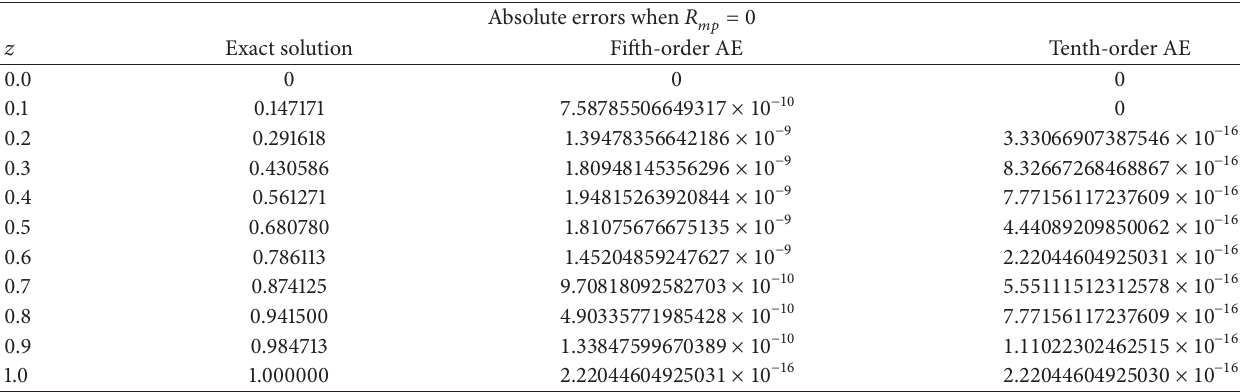
Table 4: Absolute errors of fifth- and tenth-order HAM solutions when 𝑅 𝑚𝑝 = 0